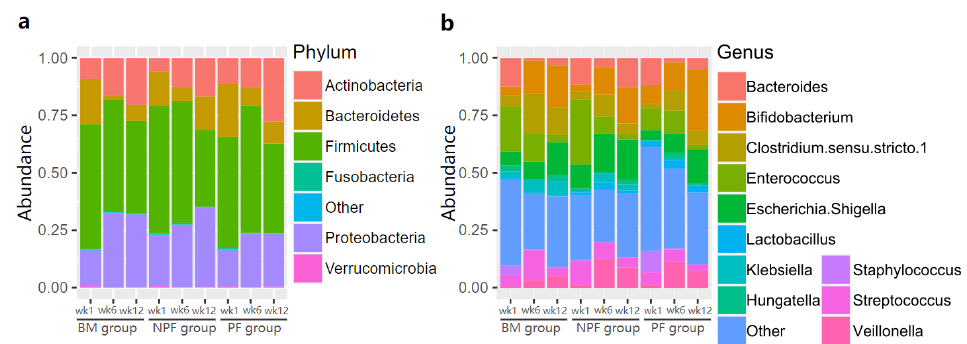
Figure 3. Relative abundance of gut microbiota at phylum level ( a ) and genus level ( b ). BM, breastmilk; PF, probiotics formula; NPF, non-probiotics formula.